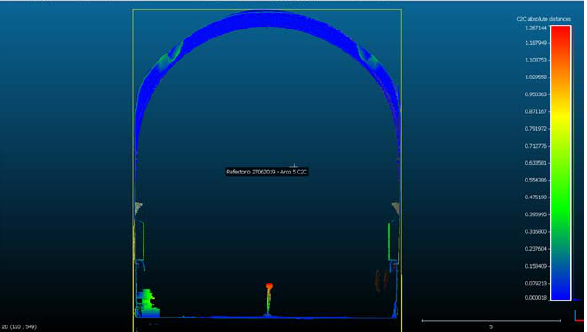
Figure 11: comparing cloud to cloud with Cloudcompare.